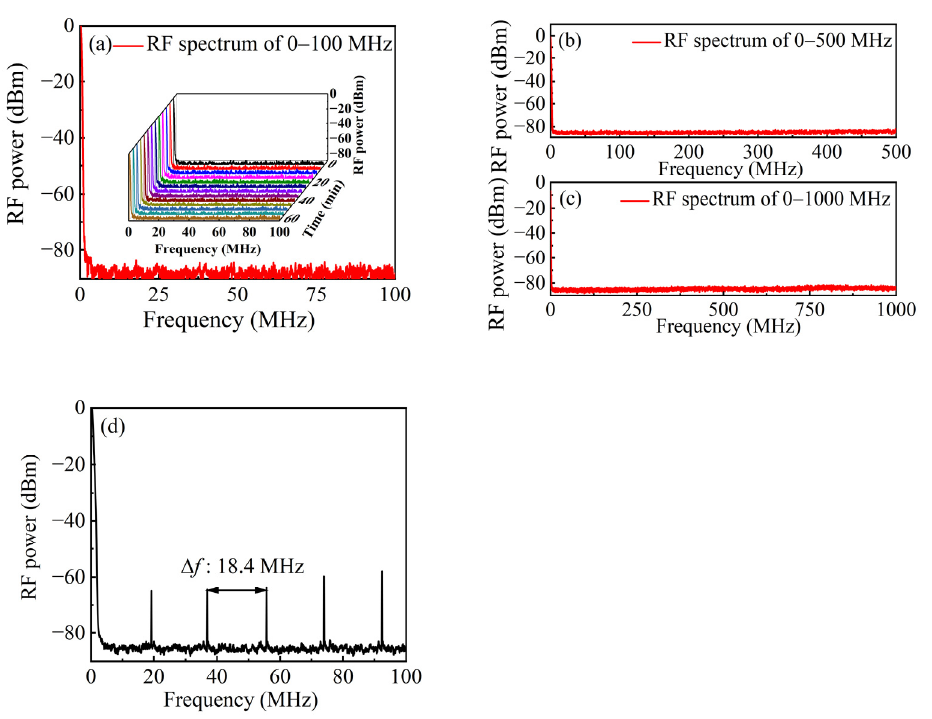
Figure 6. RF spectrum measured by signal analyzer in the range of ( a ) 0–100 MHz with a RBW of 500 kHz, ( b ) 0–500 MHz, ( c ) 0–1 GHz. ( d ) The spectrum of the main cavity without the TCR-CC filter.